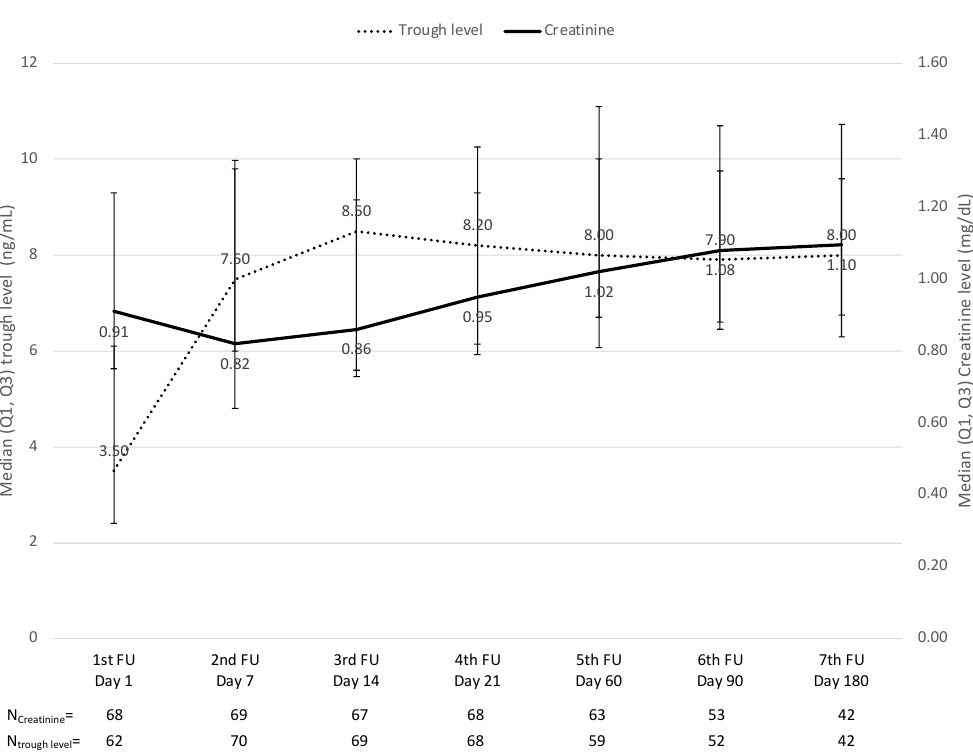
Figure 3. Liver function over time. AST, aspartate aminotransferase; ALT, alanine aminotransferase; GGT, gamma-glutamyl transferase. Note: the time points for each measurement are depicted as per the study protocol and correlate with the median actual time points. For the analysis, patients were assigned to visit numbers 1 to 8 according to their individual schedules.